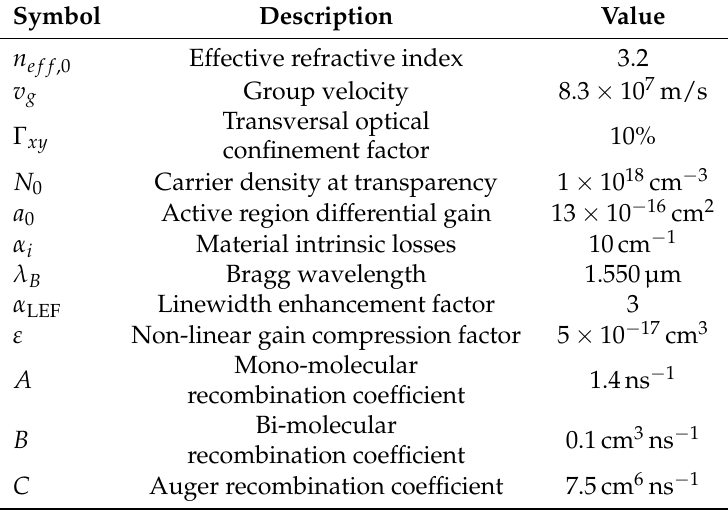
Table 1. Main material parameters used for the FDTW